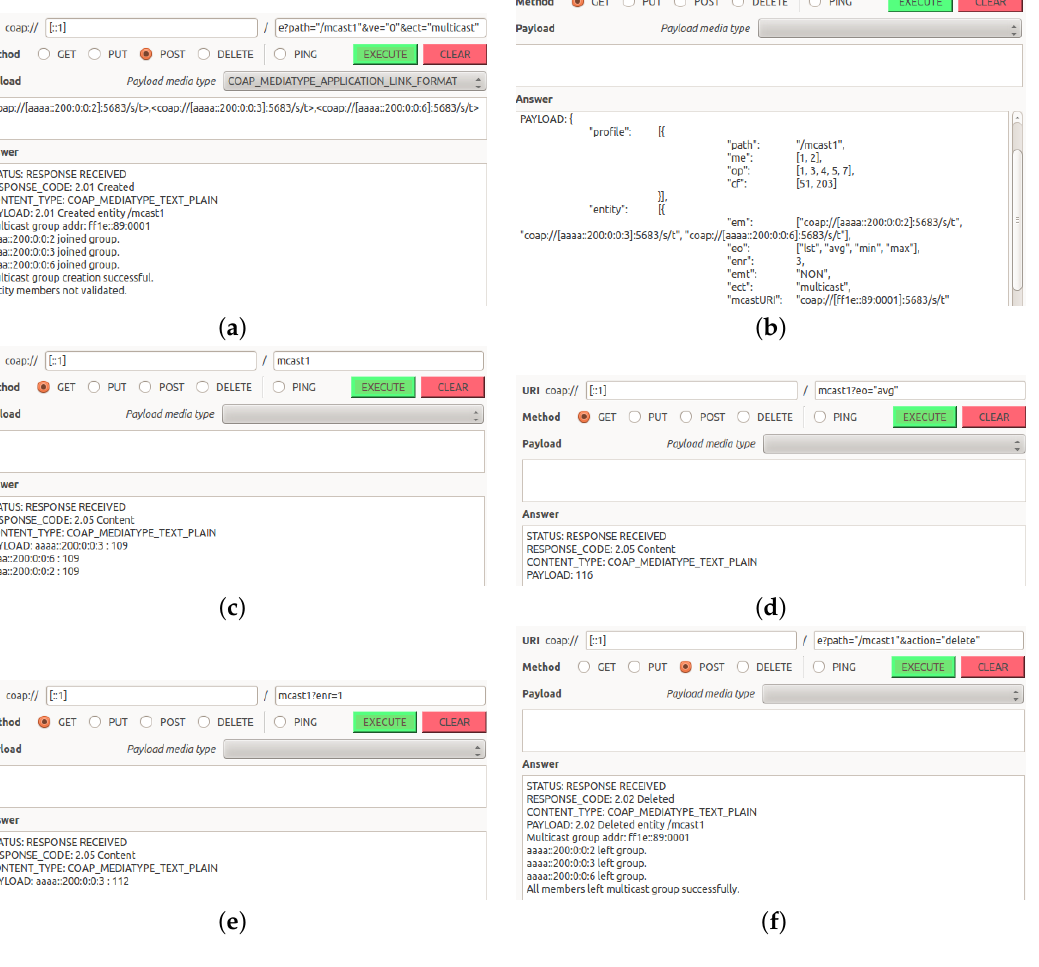
Figure 5. Screenshots using the CoAP++ client GUI to create, query and delete a multicast entity of three members. ( a ) Creating a multicast entity mcast1; ( b ) profile of mcast1; ( c ) querying mcast1 with default properties; ( d ) querying mcast1 with entity operation avg; ( e ) using mcast1 as an anycast entity; ( f ) deleting the entity